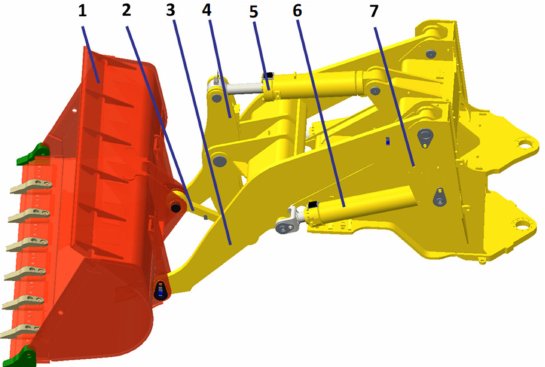
Figure 3. Working device structure drawing of loader: 1. bucket, 2. connecting rod, 3. boom, 4. swing arm, 5. bucket cylinder, 6. lifting cylinder, 7. front frame.